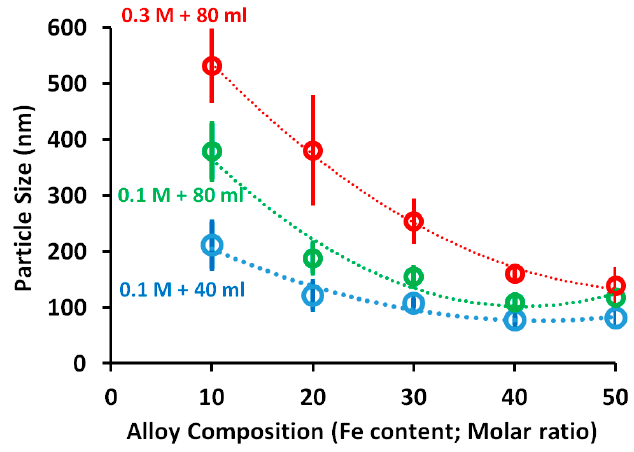
Figure 5. Particle size as function of the molar ratio of iron using ImageJ software; 40 mL reaction volume (blue circle) and 80 mL reaction volume (green circle) with 0.1 M metal concentration, 80 mL reaction volume with 0.3 M concentration (red circle).